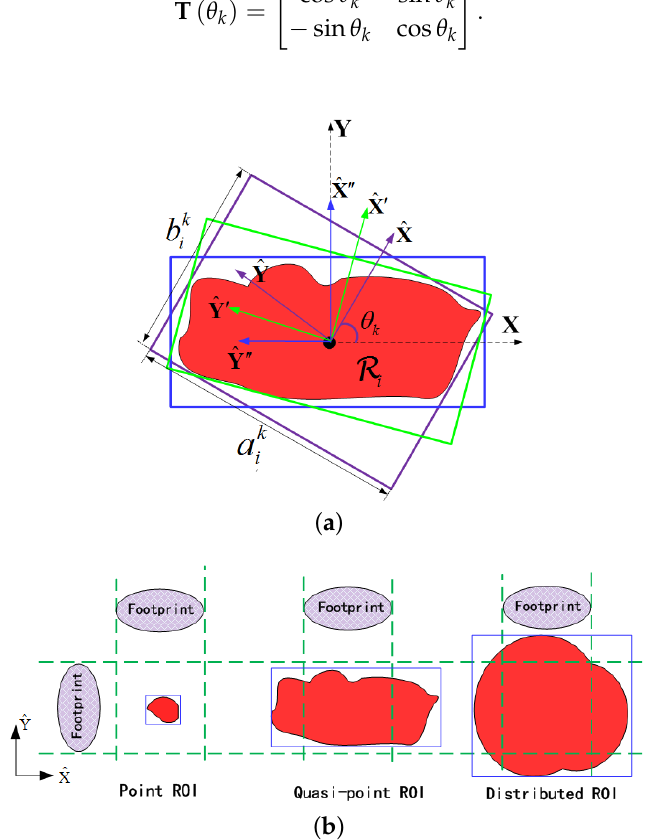
Figure 8. ROI classification via contour analysis. ( a ) MBRs of of an irregular-shaped ROI at different approach angles; ( b ) three categories of ROI classified by comparing the their MBR side-lengths with the SAR swath